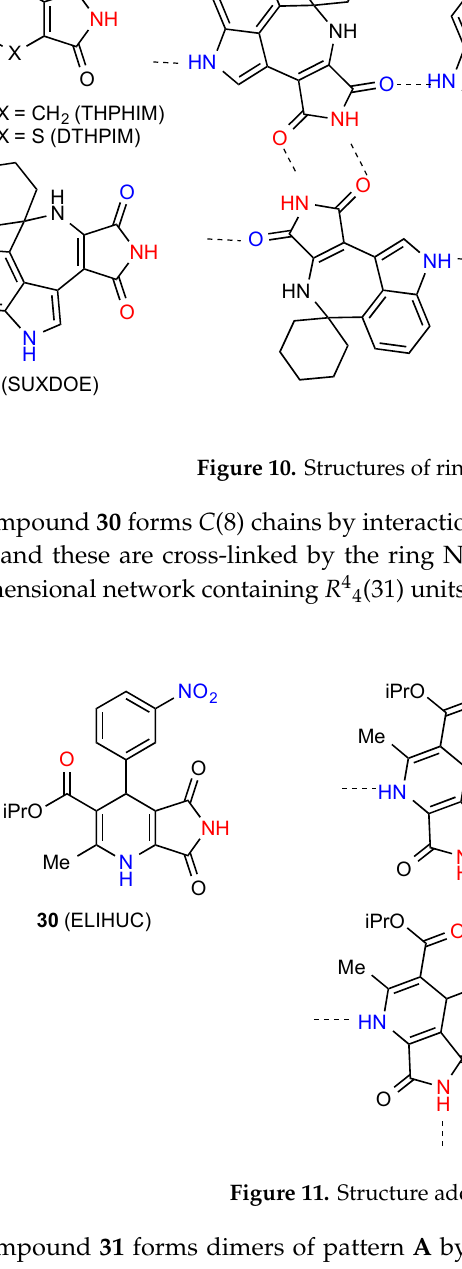
Figure 12. Structure adopted by compound 31.